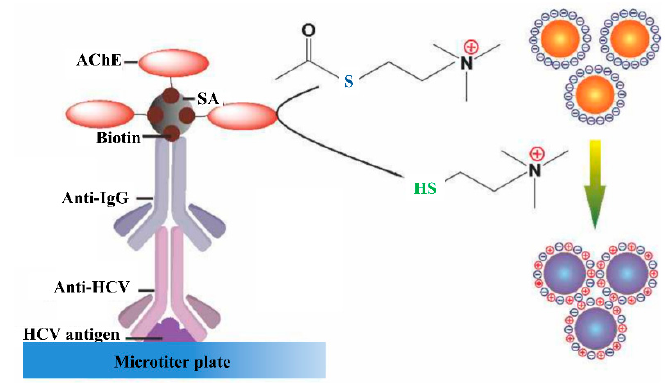
Figure 10. The GNPs in the solution phase can be triggered to form aggregates via an electrostatic interaction by thiocholine generated from AChE catalyzed hydrolysis reaction in the presence of anti-HCV antibody (adopted from Cheng Y, Tang H, Jiang J. Anal. Methods, 2017, 9, 3777–3781).